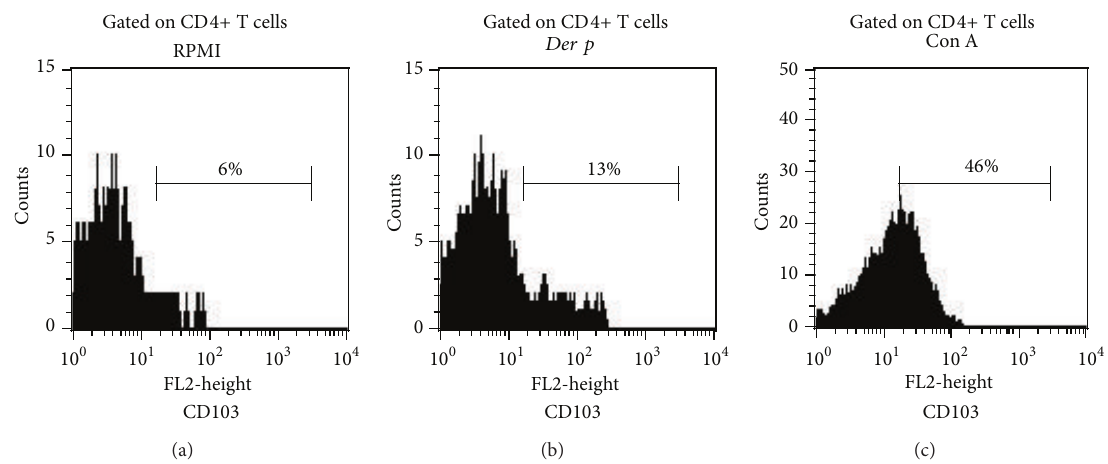
Figure 4: Increased frequency of CD4+CD103+ T cells after allergen-stimulation. (a) RPMI (nonstimulated cells, culture medium). (b) Der p -stimuli. (c) Con A mitogen (Positive stimulation control); 𝑥 -axis denotes frequency of CD103+ cells on CD4+ gated cells from patients with PAC. Representative histograms of CD4+CD103+ T cells are